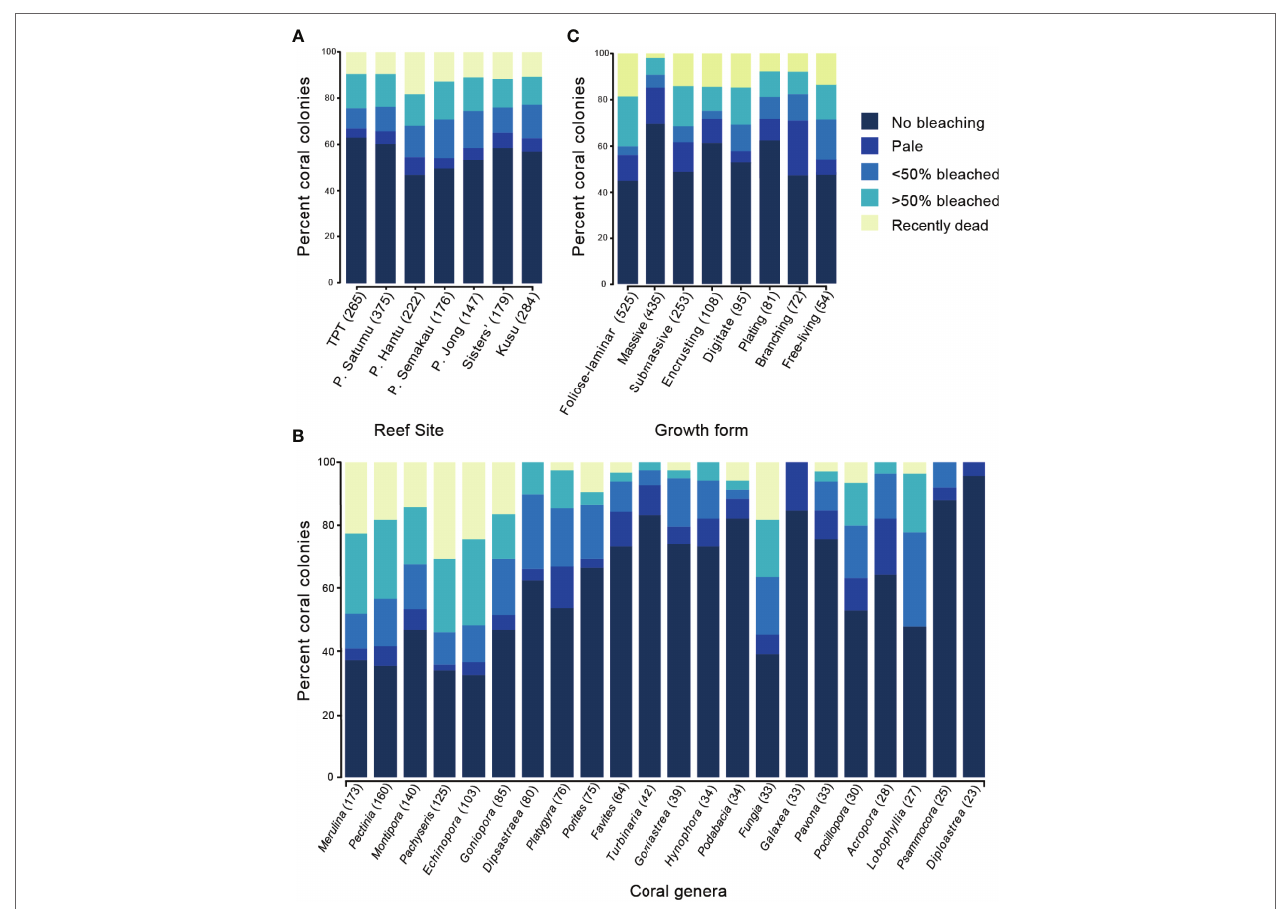
FIGURE 5 | Proportion of coral colonies in each of the five bleaching categories (no bleaching to recently dead) across (A) seven reefs in Singapore ordered from westernmost to easternmost, (B) eight most abundant coral genera ordered from highest to lowest abundance, and (C) and coral growth form ordered highest to lowest abundance. Genera with <20 colonies were